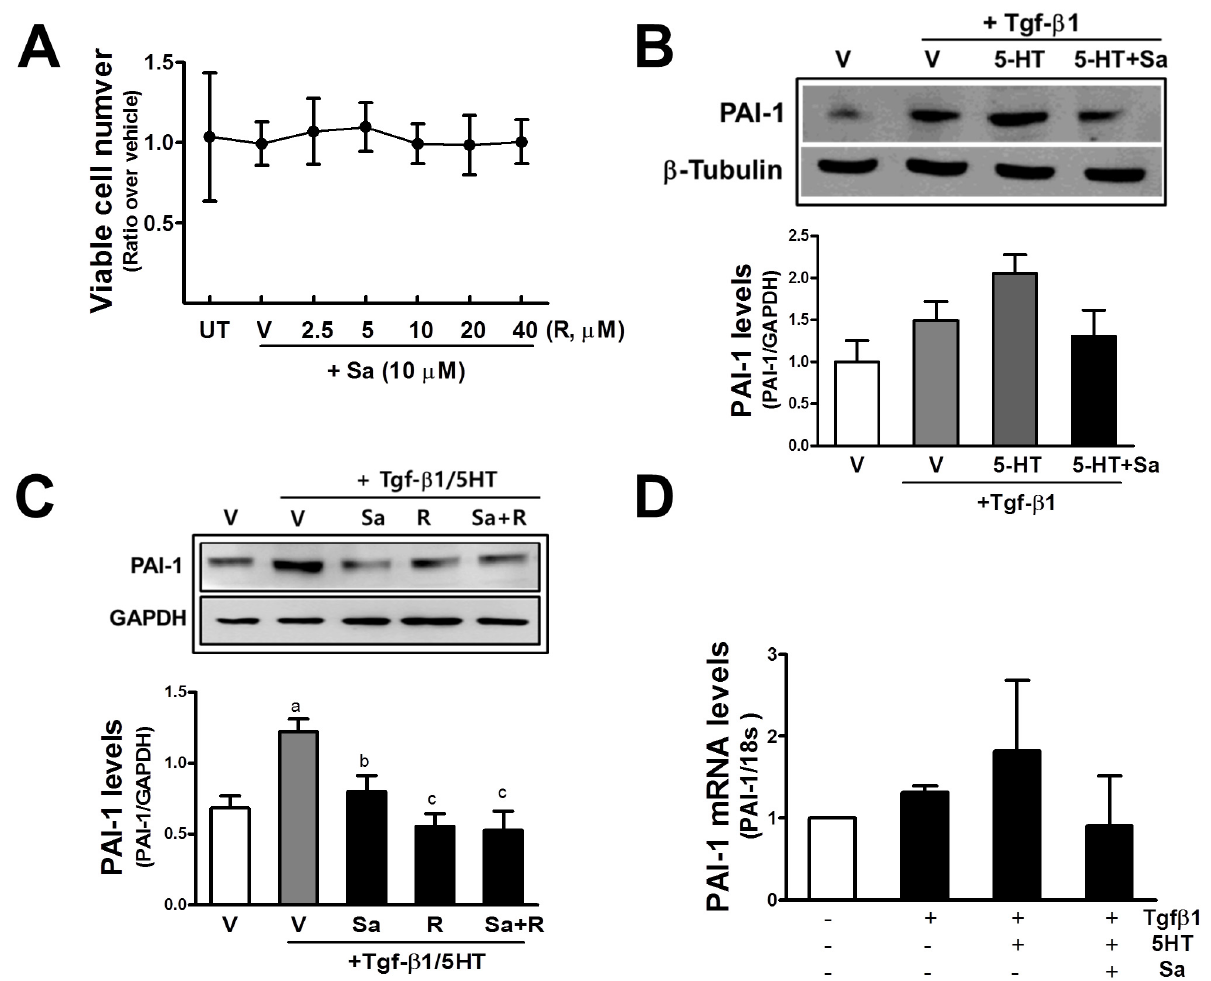
Fig 7. Suppressive effects of sarpogrelate on TGF- β 1/5-HT-mediated PAI-1 increase in mesangial cells. (A) MES13 cells were incubated with sarpogrelate (Sa, 10 μ M) along with vehicle (V, medium) or rosuvastatin (R, 2.5 – 40 μ M) for 24 h, and viable cell numbers were assessed with MTT analysis. Data represent ratios with respect to untreated (UT) control group. Data are means ± SD from three experiments. (B) MES13 cells were pre-incubated with sarpogrelate (10 μ M) for 6 h and then TGF- β 1 (10 ng/ml) was additionally incubated for 24 h along with either vehicle (V) or 5-HT (10 μ M). Levels of PAI-1 were assessed with western blotting. Data are means ± SD from three independent experiments. (C) MES13 cells were pretreated with sarpogrelate (10 μ M), rosuvastatin (10 μ M) or both for 6 h, and then TGF- β 1 (10 ng/ml) and 5-HT (10 μ M) were co-incubated for a further 24 h. Data are means ± SD from three independent experiments. (D) After the treatment of MES13 with sarpogrelate and TGF- β 1/5-HT, transcript levels for PAI-1 were quantified with relative real- time RT-PCR analysis. Sarpogrelate was pre-incubated for 6 h and the TGF- β 1/5-HT incubation was followed for a further 24 h. Data are means ± SD from three